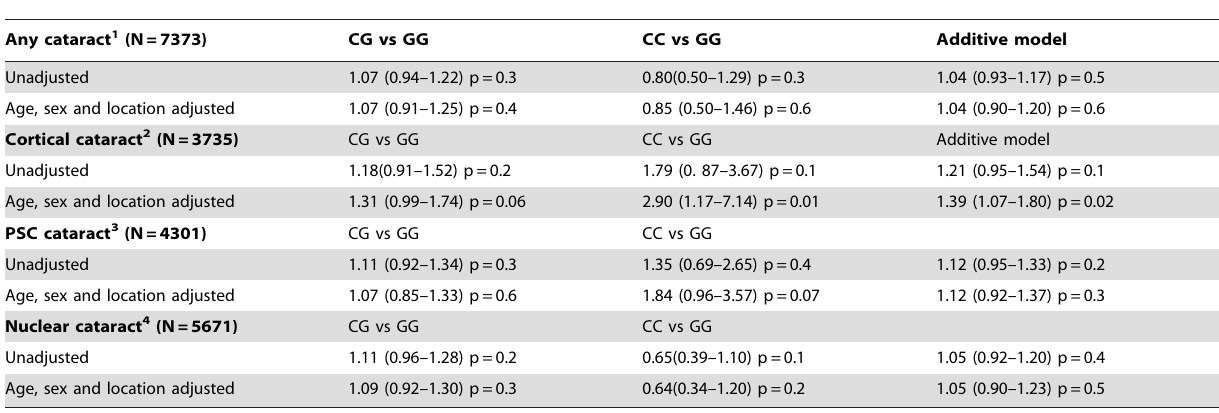
Table 5. Associations between cataract and rs11260867.